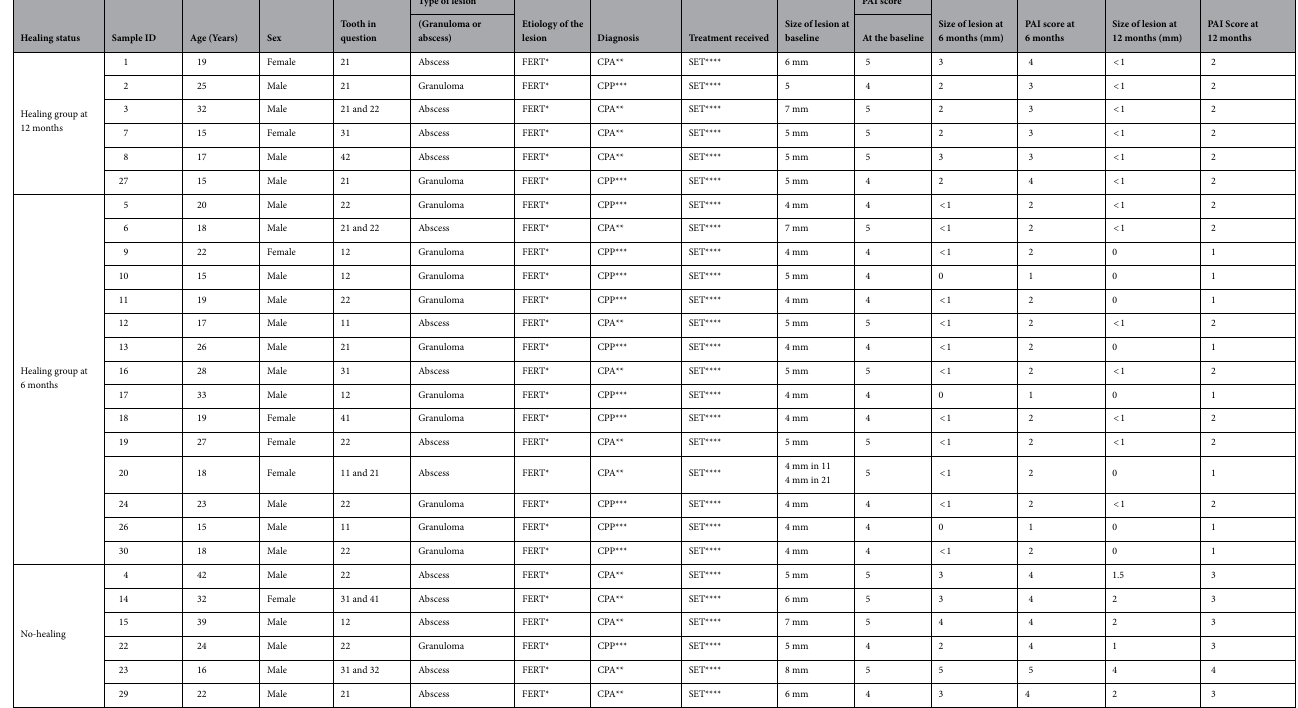
Table 2. The demographic information and clinical details about the patients in the study. * FET failed endodontic treatment, ** CPA chronic periapical abscess, *** CPP chronic periapical periodontitis; **** SET surgical endodontic treatment.